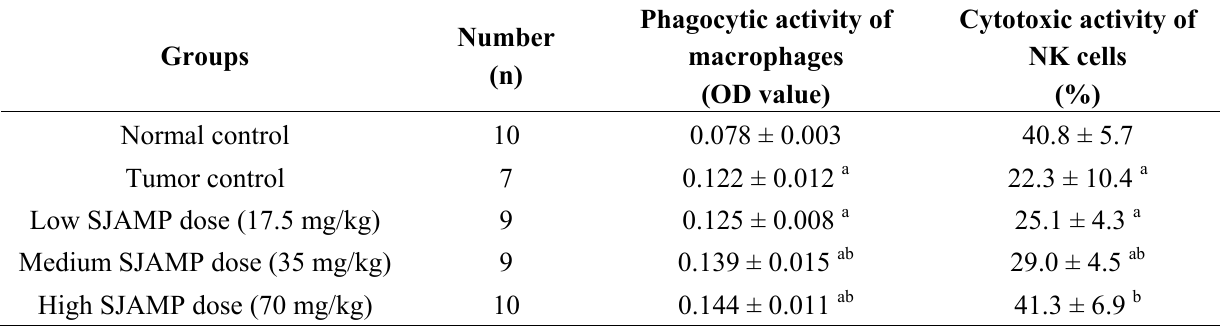
Table 6. Effect of SJAMP on the phagocytic activity of macrophage and the cytotoxic activity of NK cells in rats with DEN-induced HCC ( x ±